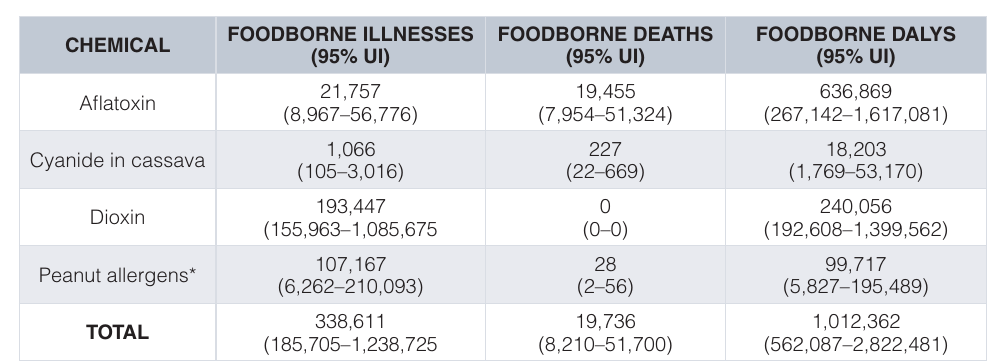
Table 1. Median number of foodborne illnesses, deaths, and DALYs, with 95% UIs, 2010.